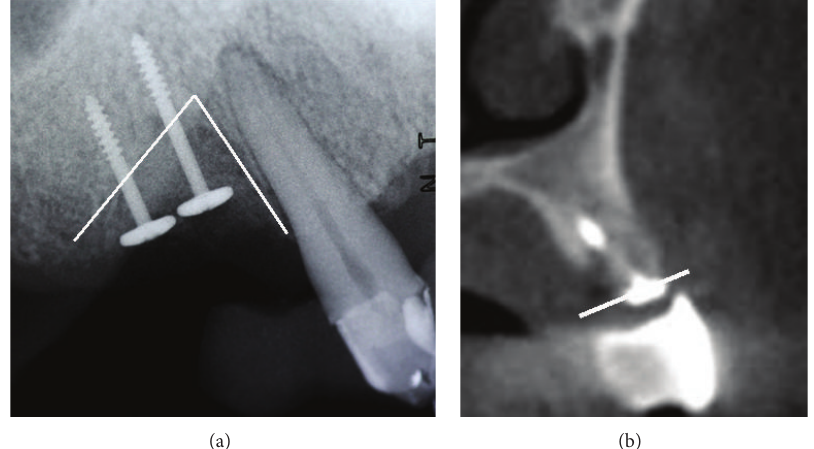
Figure 4: (a) Tenting screw technology for implant # 5 site development. (b) Significant bone increase in vertical and horizontal dimensions, confirmed by the CBCT sagittal slice.